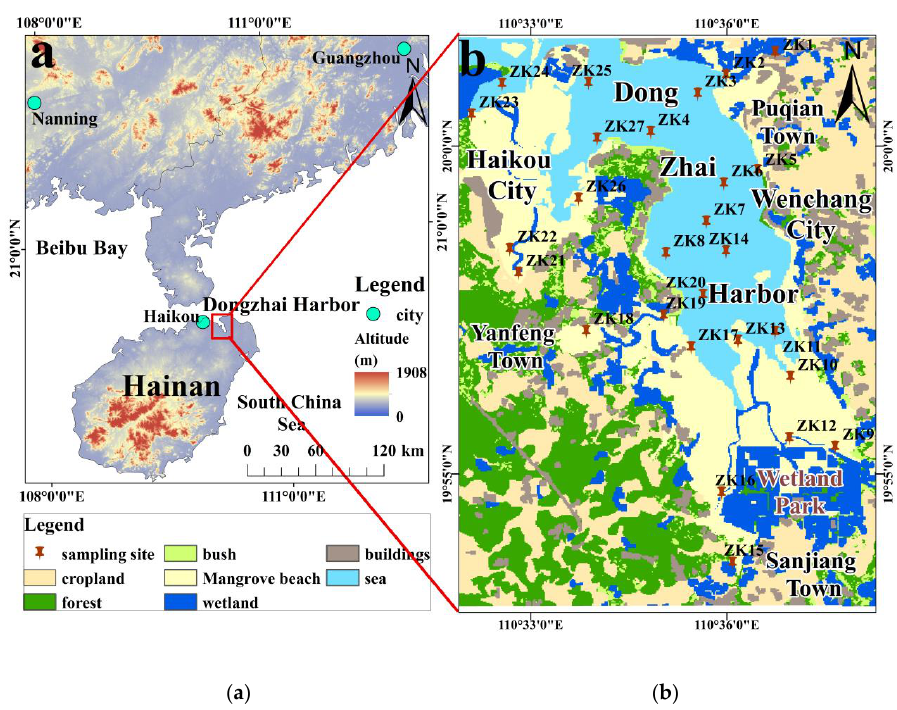
Figure 1. ( a ) Geographic location of the study area, and ( b ) The locations of the sampling